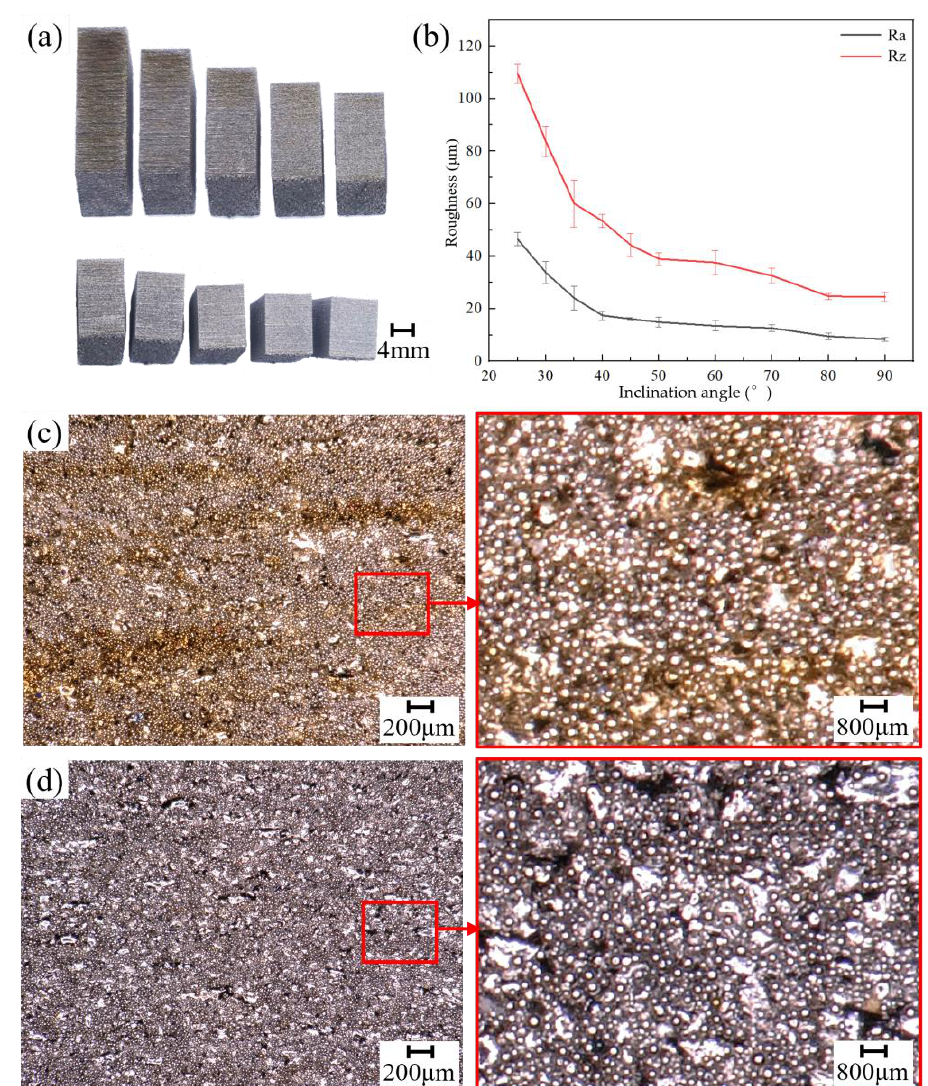
Figure 12. Lower side of parts with different inclination angles: ( a ) forming effect; ( b ) roughness curves; ( c ) 25° macroscopic morphology; ( d ) 90° macroscopic morphology.